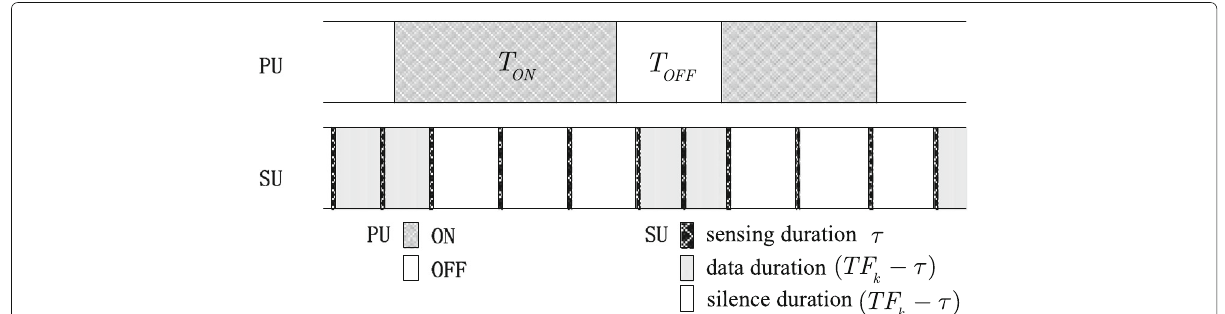
Fig. 1 The PU’s activity and the SU’s sensing